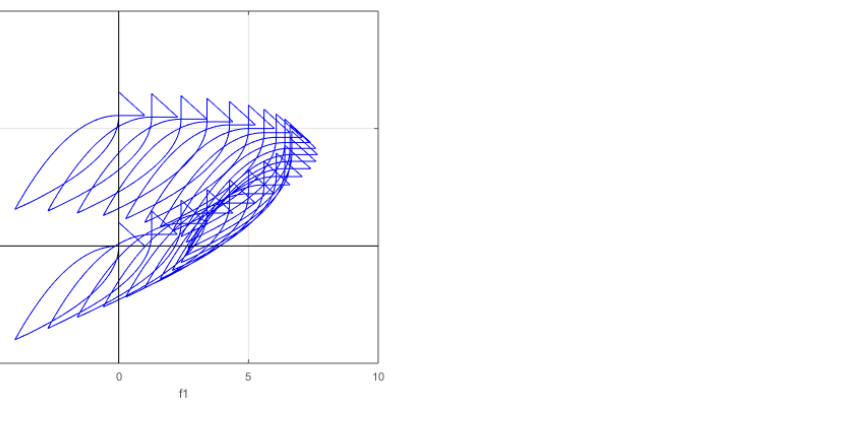
Figure 3. Construction of the payoff space of the parametric game G µ . Here, we represent the games G µ ( z ) for some values of z .